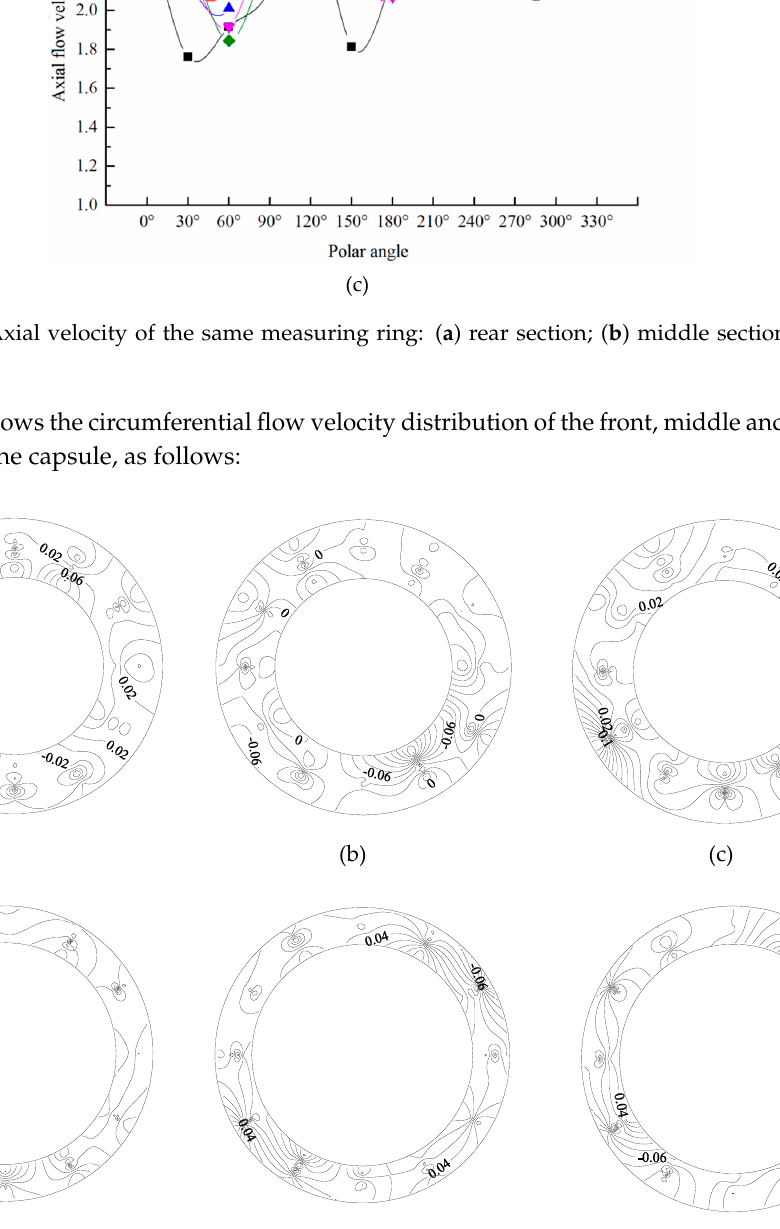
Figure 13. Axial velocity of the same measuring ring: ( a ) rear section; ( b ) middle section; and ( c ) front section.